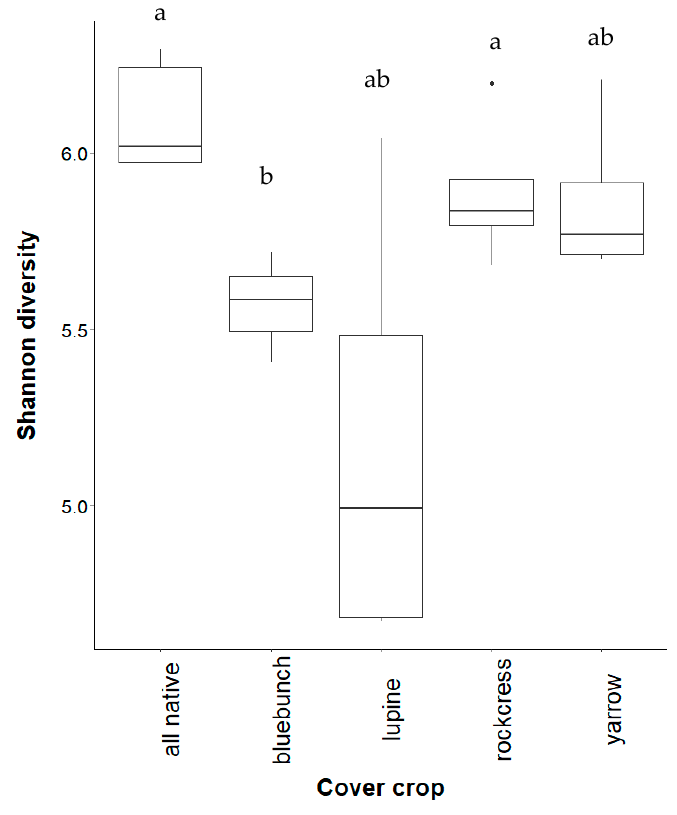
Figure 4. Shannon diversity of fungi in native study soils. Treatments are bluebunch wheatgrass (“bluebunch”), silky lupine (“lupine”), Holboell’s rockcress (“rockcress”), and white yarrow (“yarrow”). Overall group significance was observed in monocultures ( p = 0.047). Letters over treatments indicate pairwise differences at a significance level of 0.05.